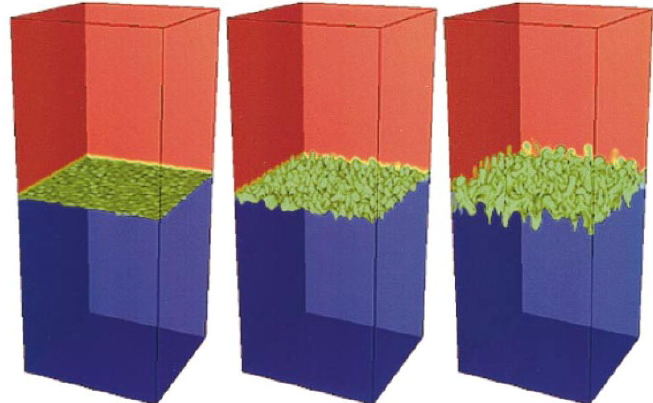
Figure 1. Density field of Rayleigh-Taylor instability [5].